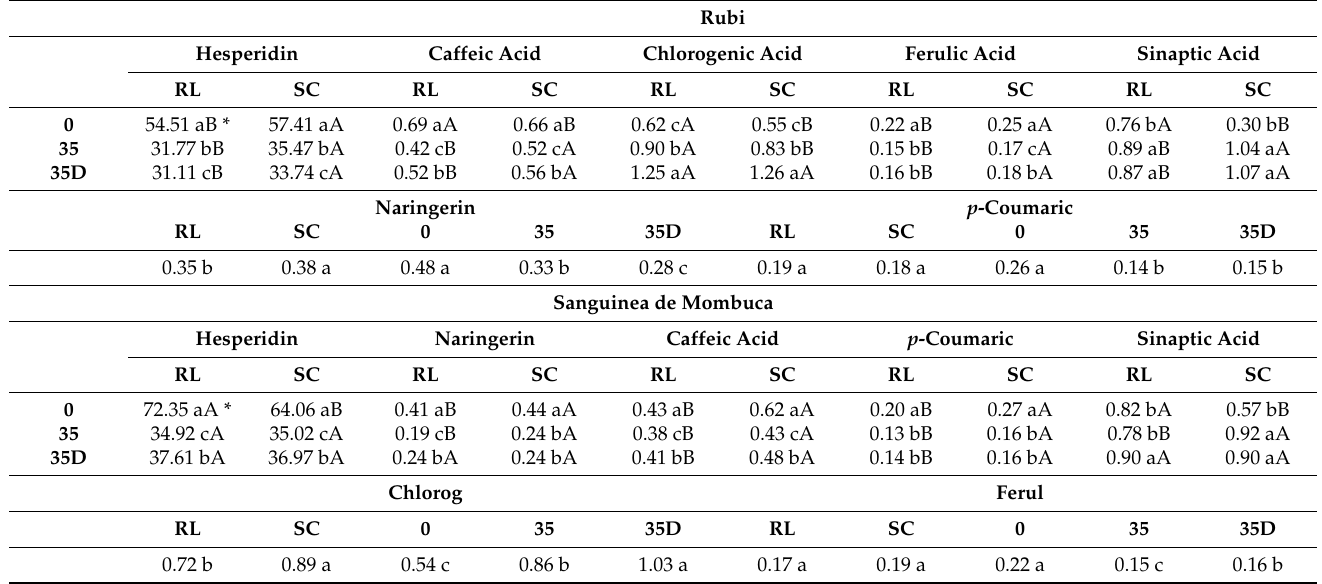
Table 4. Concentration of phenolic compounds (mg/L) in ‘Rubi’ and ‘Sanguinea de Mombuca’ juices with different combinations of rootstock subjected to 35 days of storage in transparent bottles and dark bottles (D).